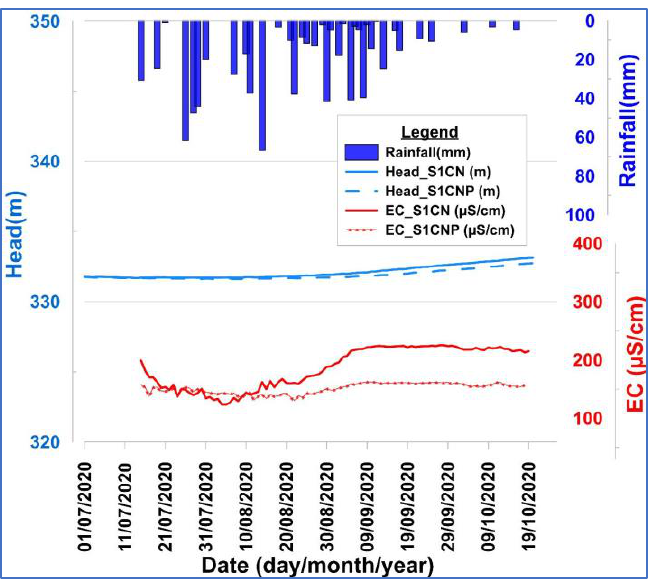
Figure 13. Groundwater hydrographs versus electrical conductivity in relation to rainfall at the northern ridge.